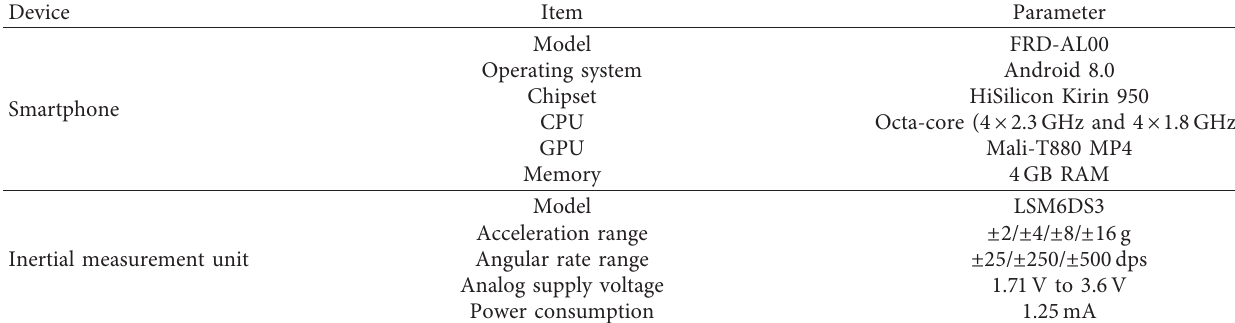
Figure 3: Data collection framework for this study. Table 1: Parameters about the smartphone and